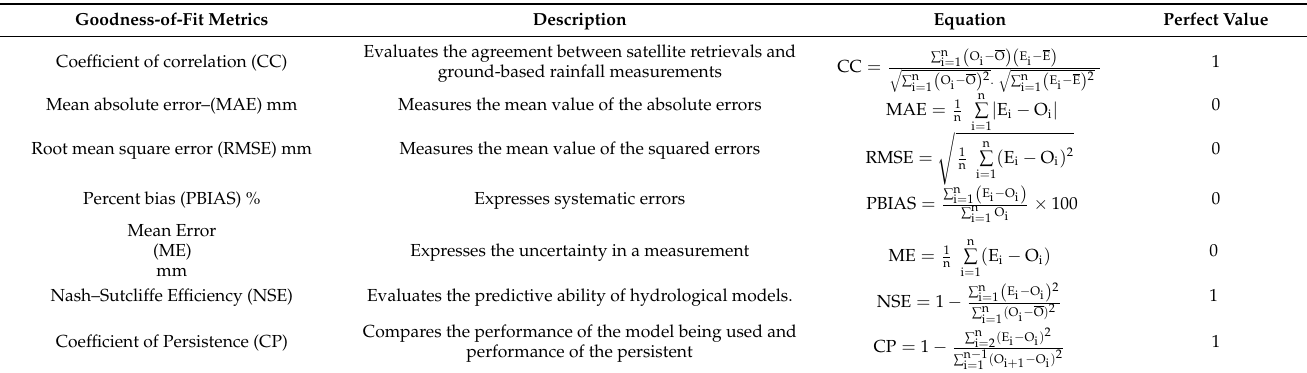
Table 2. Goodness-of-fit metrics utilized in the comparison of the GPM precipitation product and the ground-based